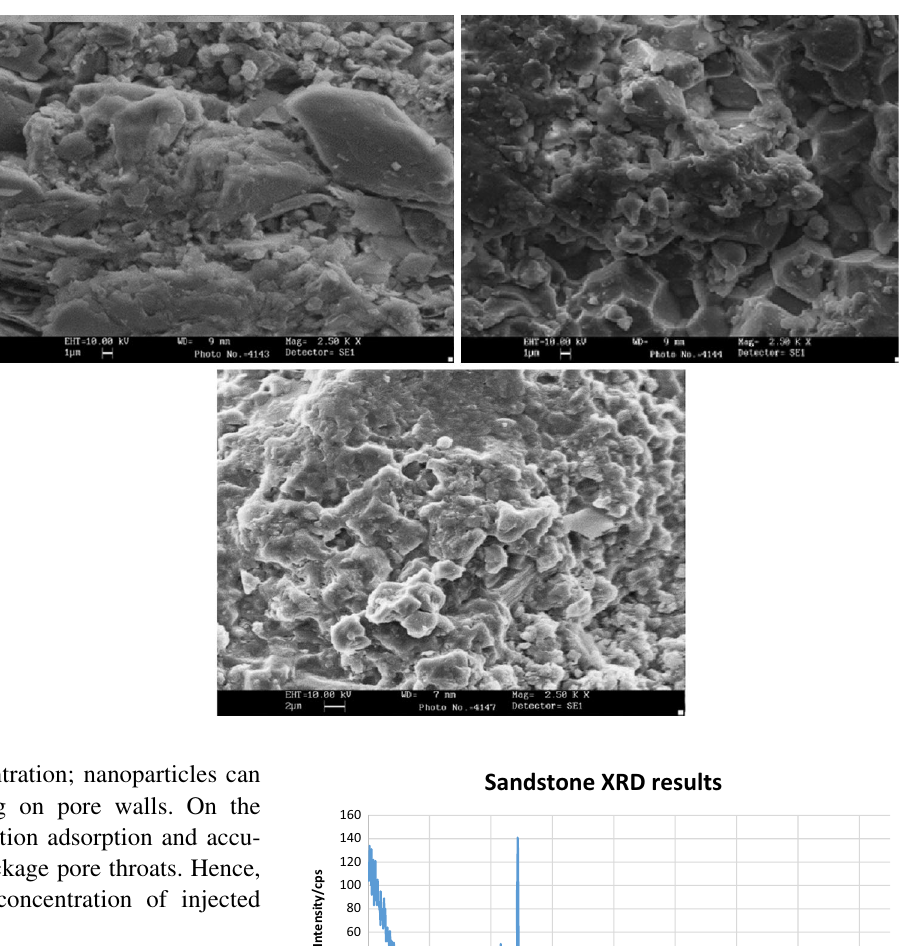
Fig. 14 SEM image of core samples before and after nano- flooding [ Left before nano- flooding, middle after nano- flood (2000 ppm), bottom after nano-flood (5000 ppm)]